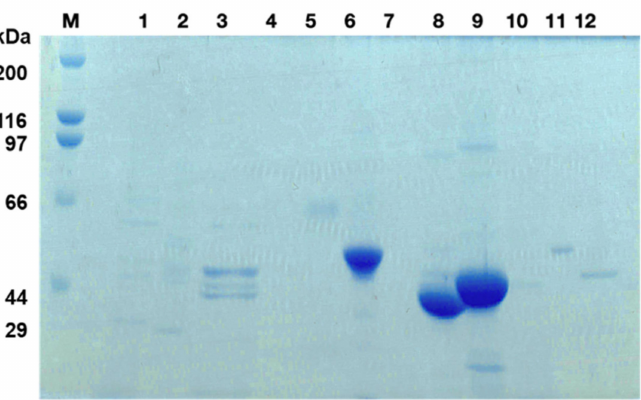
Figure 3. Sodium dodecyl sulphate-10% polyacrylamide gel electrophoresis (SDS-10%PAGE) analysis of 5 M LiCl released proteins. Lane 1: L. plantarum subsp. plantarum JCM 1149, lane 2: L. lactic subsp. cremoris NZ 9000, lane 3: L. amylovorus JCM 1126, lane 4: L. paracasei subsp. paracasei JCM 8130, lane 5: L. kefiri JCM 5818, lane 6: L. brevis JCM 1059, lane 7: L. plantarum JCM 1100, lane 8: L. helveticus JCM 1120, lane 9: L. acidophilus JCM 1132, lane 10: L. plantarum TIN- KL 001, lane 11: L. lactis subsp. lactis IL1403, lane 12: L. rhamnosus JCM 1136 and lane M: Marker